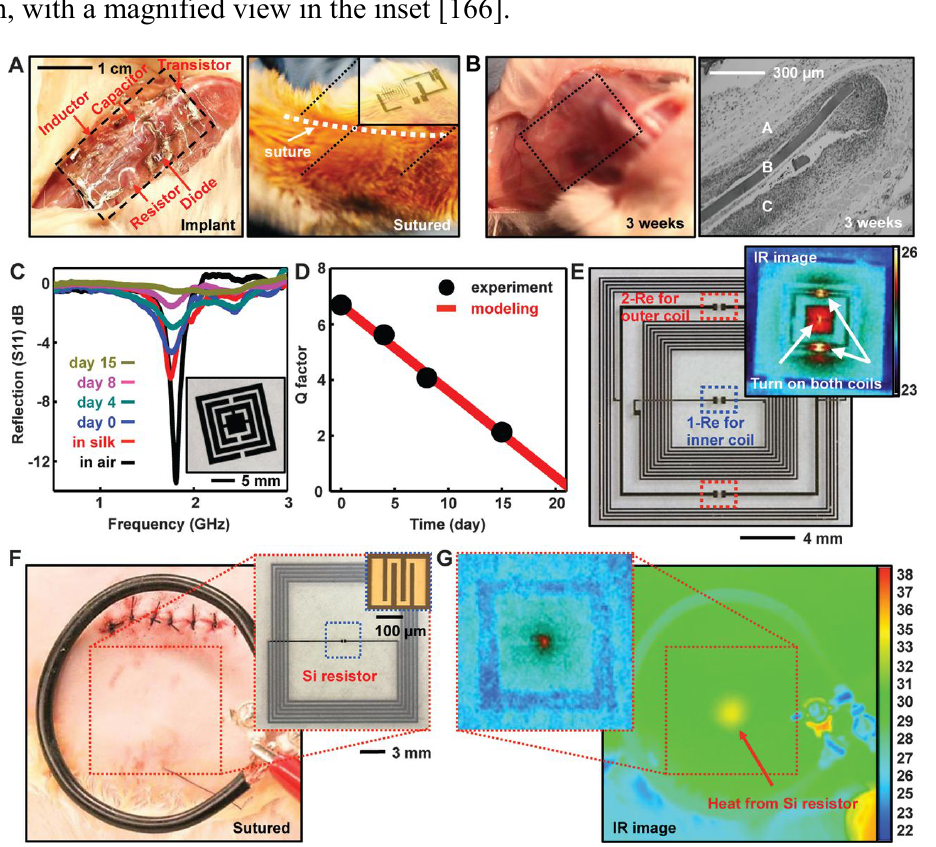
Figure 3. In vivo evaluations and example of a transient bioresorbable device for thermal therapy. ( A ) Images of an implanted and sutured transient electronics platform located in the subdermal dorsal region of a BALB/c mouse. ( B ) Implant site and histological section of tissue at the implant site, excised after 3 weeks, showing a partially resorbed region of the silk film. ( C ) Resonant responses of an implanted transient RF metamaterial structure before and after placement in a silk package, immediately after implantation and at several time intervals thereafter. ( D ) Measured and calculated Q factor for the metamaterial, where the results indicate transience dominated by the diffusion of biofluids through the silk package. ( E ) Transient wireless device for thermal therapy, consisting of two resistors (red outline) connected to a first wireless coil (70 MHz; outer coil) and a second resistor (blue outline) connected to a second, independently addressable, wireless coil (140 MHz; inner coil). The inset shows a thermal image of this device coupled with a primary coil operating at two frequencies, to drive both the inner and outer coils simultaneously. ( F ) Primary coil next to a sutured implant site for a transient thermal therapy device, with the inset showing an image of a device. ( G ) Thermal image collected while wirelessly powering the device through the skin; the results show a hot spot (5 °C above background) at the expected location, with a magnified view in the inset